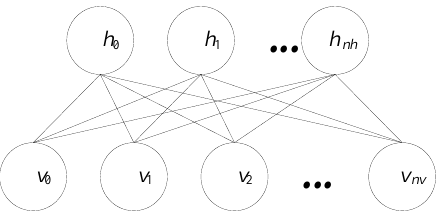
Figure 1. Illustration of the network connections with a GRBM. Note the GRBM exhibits same structure compared to its RBM counterpart.